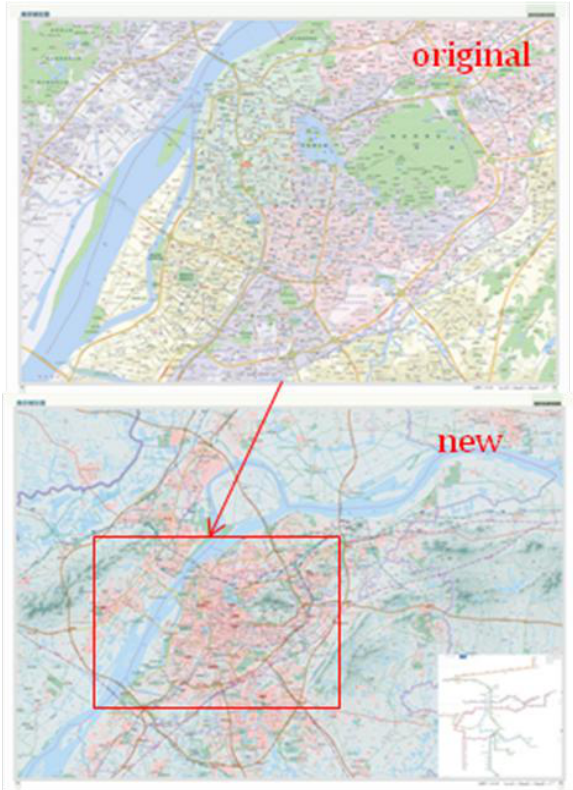
Figure 1. the comparison on scope and characteristic of original and new city map